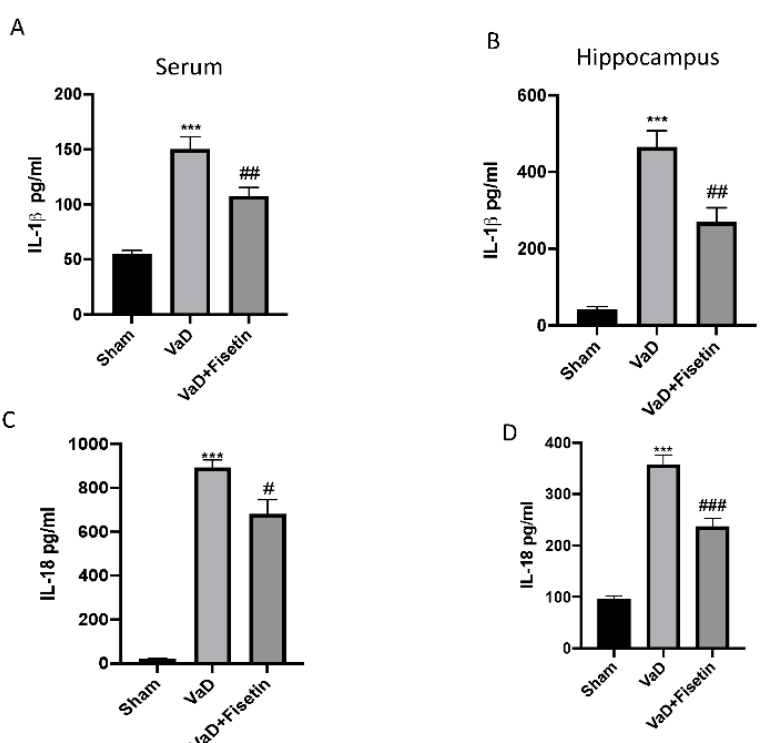
Figure 8. Evaluation of serum and hippocampus cytokine levels. Serum and hippocampus levels of IL-1 β ( A , B ); serum and hippocampus levels of IL-18 ( C , D ). Values are means ± SEM of 6 animals for each group. *** p < 0.001 vs. sham; ## p < 0.01 vs. VaD, ### p < 0.001 vs. VaD, # p < 0.05 vs. VaD.